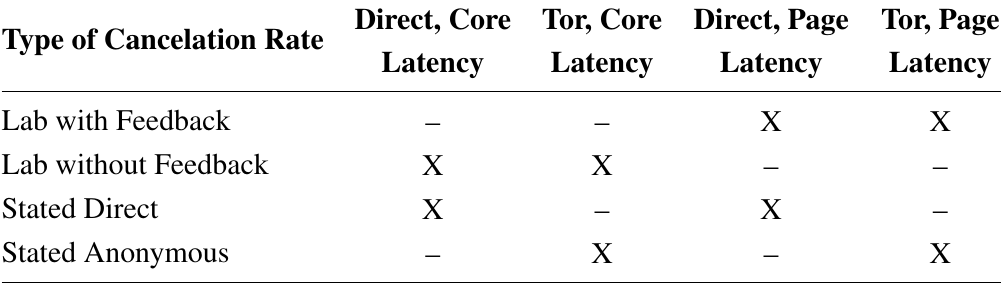
Table 4. Comparing Cancelation Rates from User Studies to our Latency